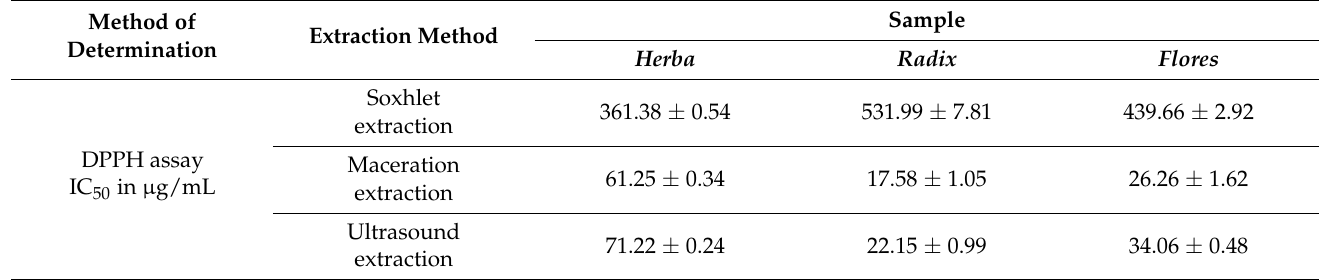
Table 4. Antioxidant activity results acquired for the tested Lysimachia nummularia L.